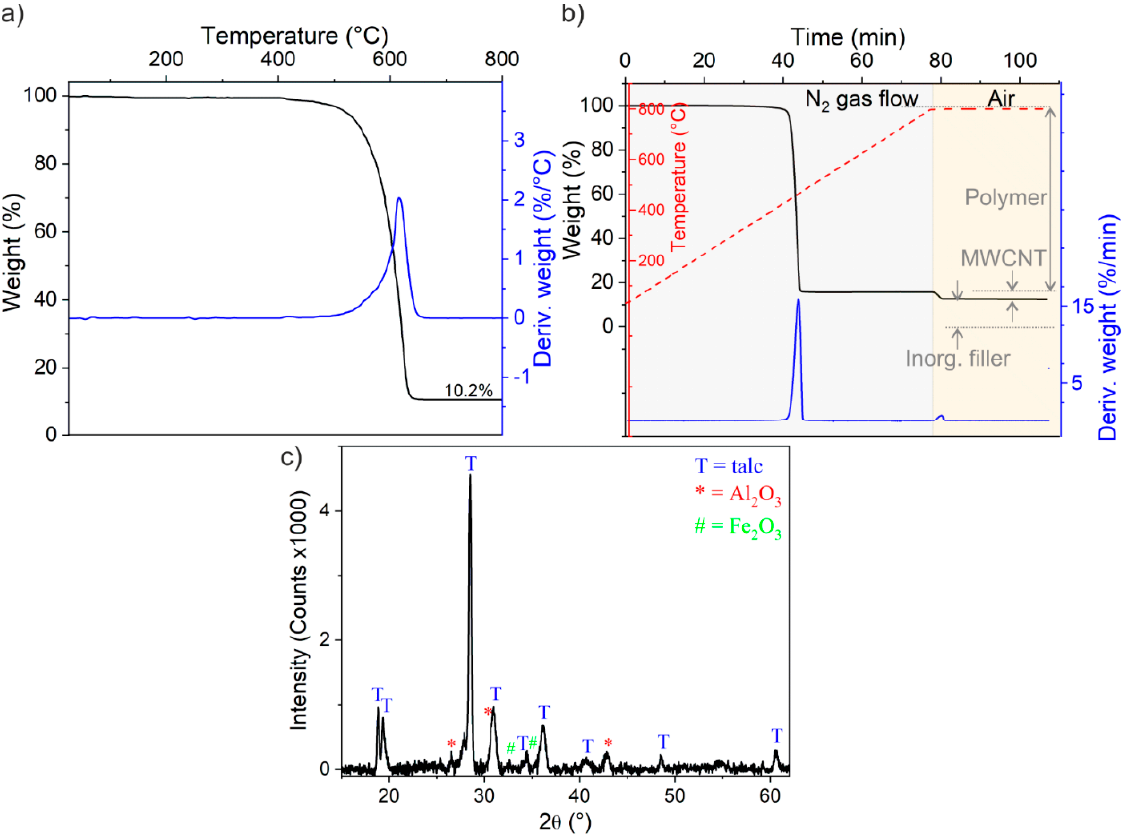
Figure 2. Thermogravimetric (TG) and difference thermogravimetric (DTG) plots (black and blue curves, respectively) of: ( a ) multi-walled carbon nanotubes (MWCNTs) in air, ( b ) melt-compounded MWCNT/polypropylene (PP) composite (4wt.% of MWCNTs) heated under N 2 gas flow followed by an isotherm in air at 800 ◦ C (the thermal profile is in red color); ( c ) X-ray diffraction (XRD) pattern obtained on residue after TGA thermal treatment. Talc (T peaks in the XRD pattern) is indexed with Magnesium silicate hydroxide (PDF card #29-1493) reference pattern. The XRD pattern could be entirely indexed with the reference patterns. Table 1. Composition of MWCNTs and of the compounded MWCNT/PP composites.